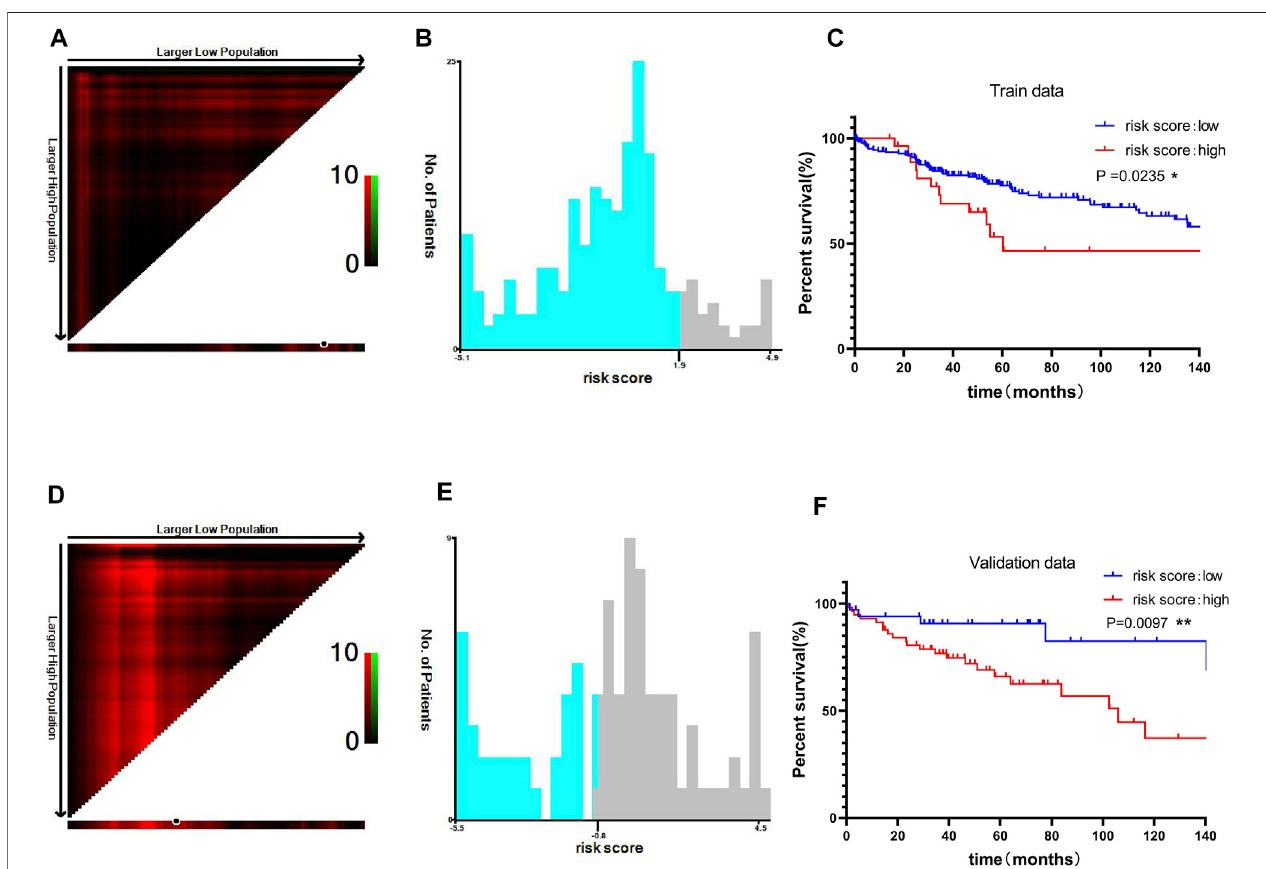
FIGURE7| Prognosticanalysisusingtheriskscoresinthetrainingandvalidationsets.OptimalcutoffvalueoftheriskscoredividedbyX-tilesoftwareinthetraining data (A, B) (C) Kaplan-Meier curve of the two groups divided by the cutoff value in the training data. The optimal cutoff value of the risk score was divided by the X-tile software in the validation data (D, E) (F) Kaplan-Meier curve of the two groups divided by the cutoff value in the validation data. * p < 0.05, ** p < 0.01 and *** p <